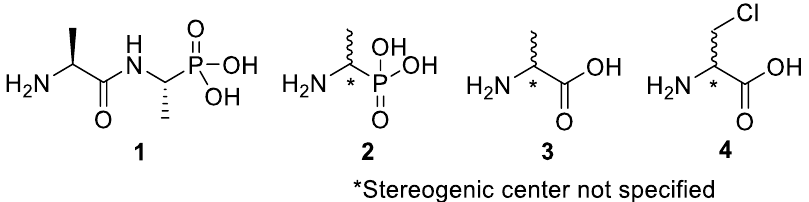
Figure 1. Structures of L -alanyl- L -fosfalin 1 , fosfalin 2 , alanine 3 , β -chloroalanine 4 .